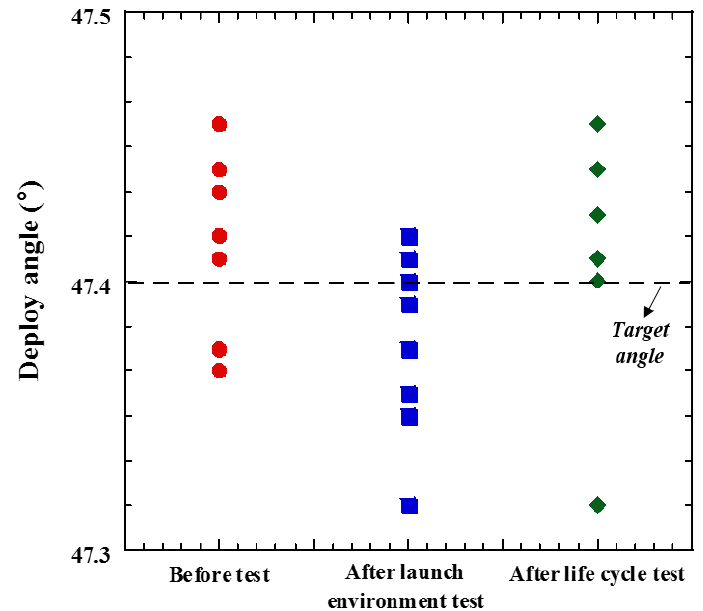
Figure 13. Measured deployed angles before and after each test.